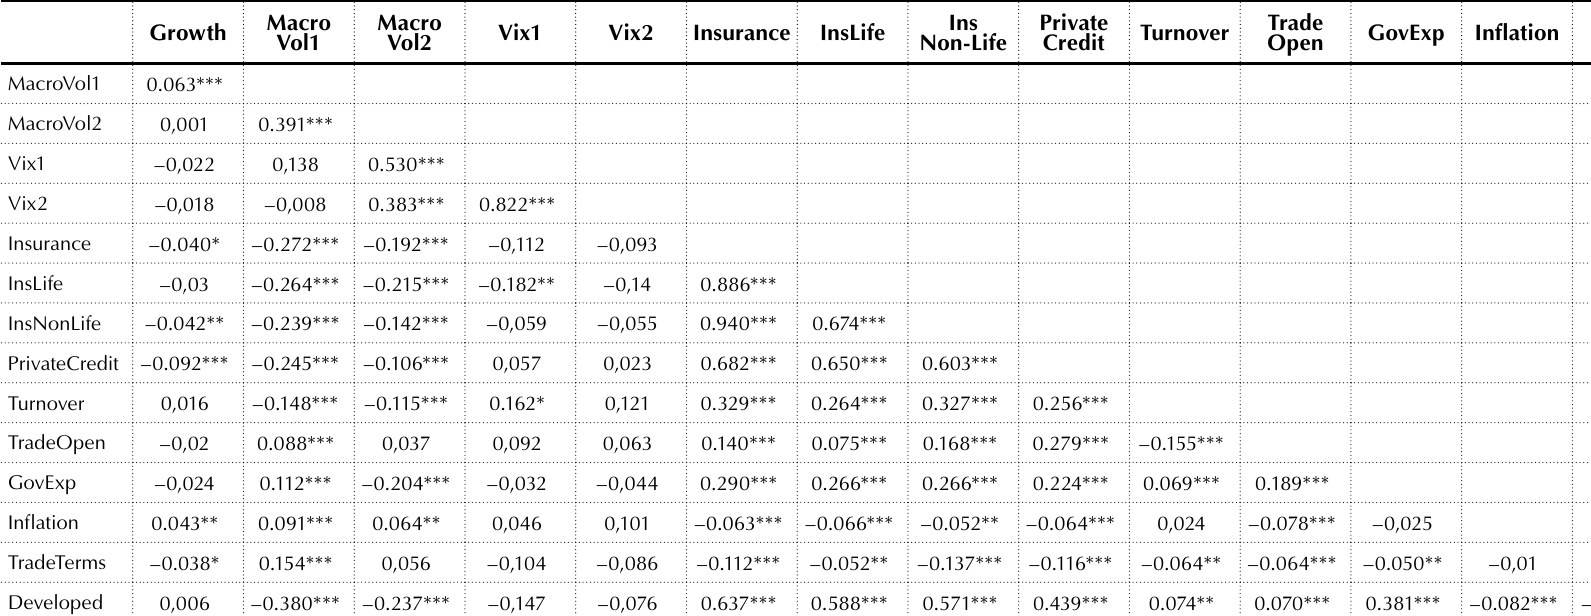
Table 3. Correlation